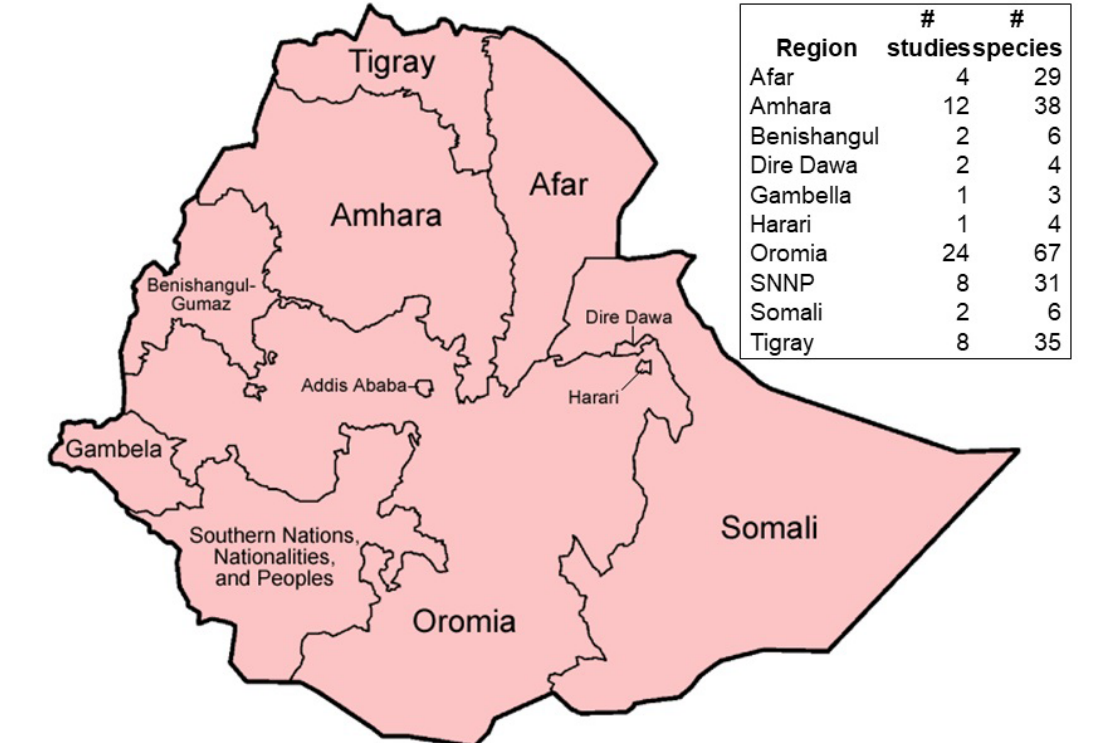
Figure 2. Regional distribution in Ethiopia of studies and ethnomedicinal plants used against snakebites (modified after https://commons.wikimedia.org/wiki/